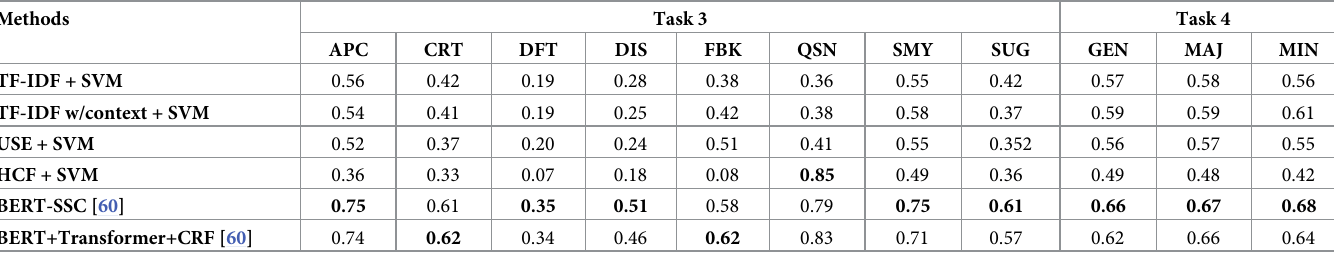
Table 7. Label-wise F1 scores (micro-averaged) for Task 3 and Task 4. Methods